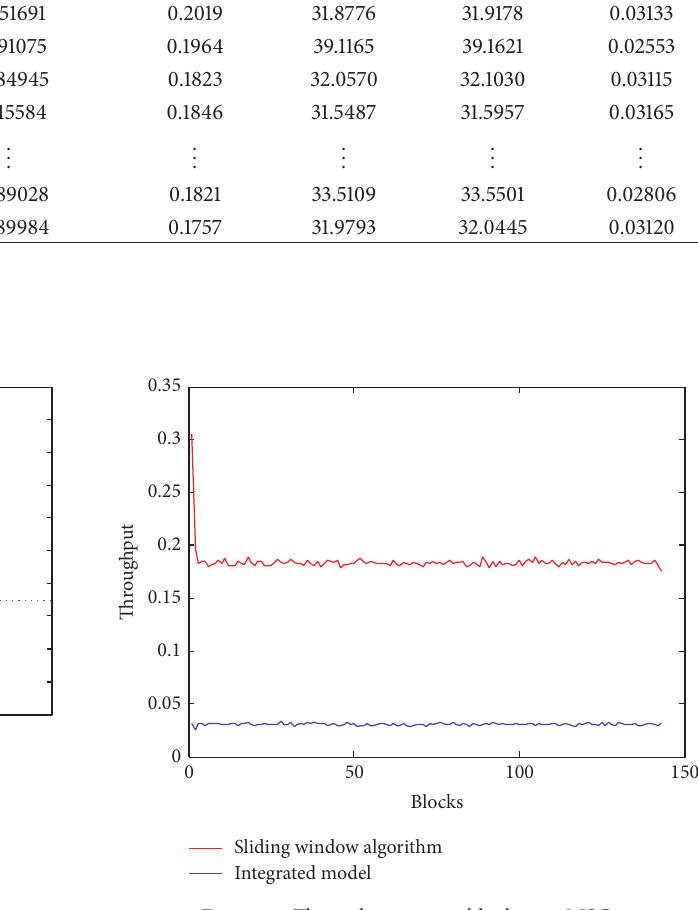
Figure 7: Throughput versus blocks at a